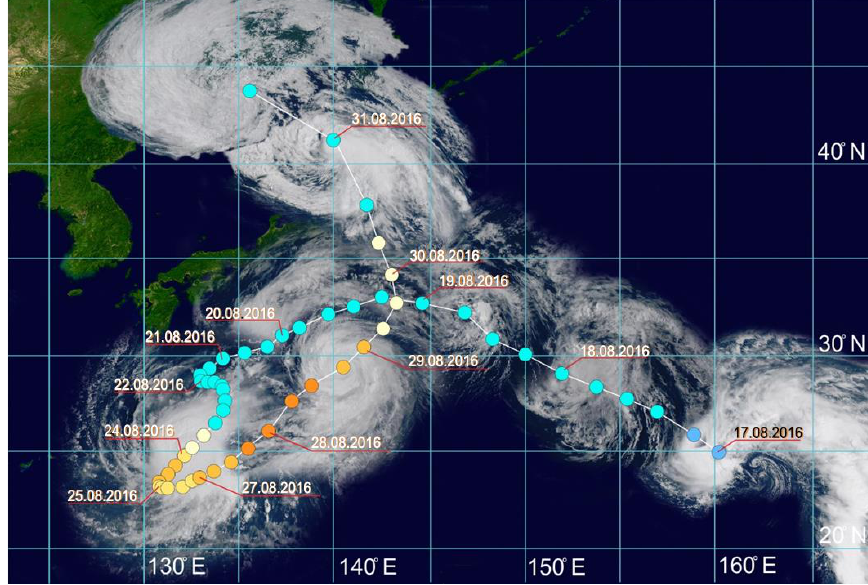
Figure 3. Typhoon Lionrock trajectory aligned with the images made by the “Himawari - 8” satellite in the visible range.